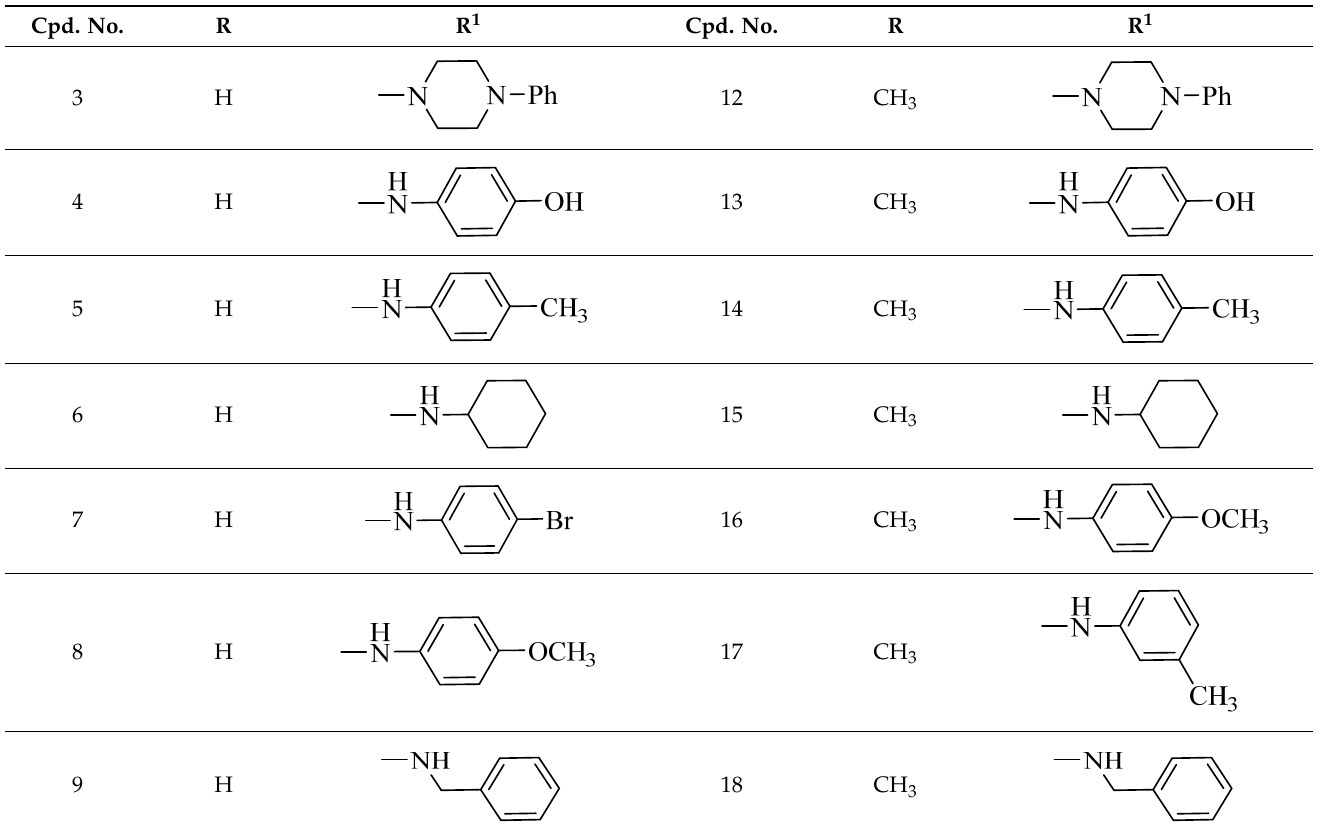
Figure 3. Scheme for the preparation of the candidate compounds. Table 1. Detailed structure of the semi synthesized compounds 3 – 20 . Cpd. No.